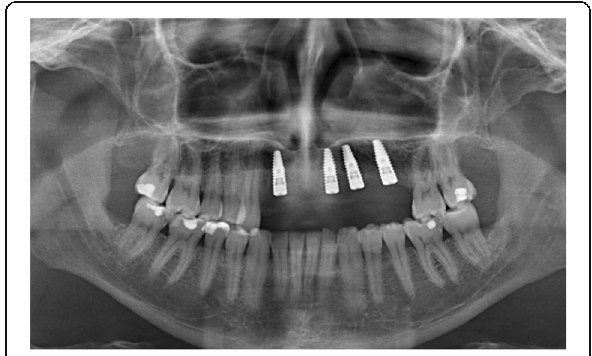
Fig. 7 Orthopantomogram after implant